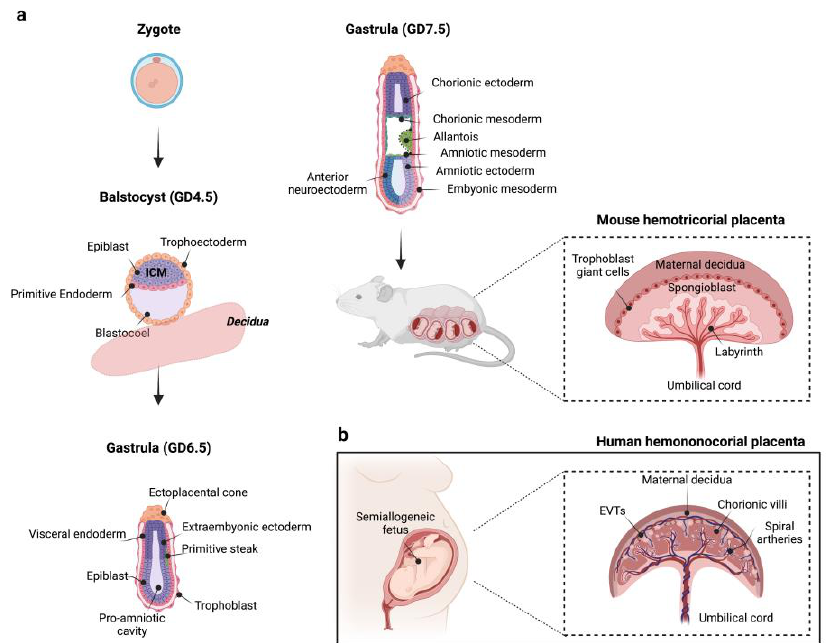
Figure 1. ( a ) A schematic representation of mouse placenta development. At gestational day (GD) 3.5–5.0, the mouse blastocyst is composed by ICM, which contains precursor cells for embryonic tissues (epiblast), and visceral and parietal endoderm (primitive endoderm), and by an outer cell layer called trophectoderm. Starting from GD 5.0–6.5, the polar trophectoderm differentiates in the ectoplacental cone, which gives origin to invading trophoblasts and junctional zone, and in the extraembryonic trophectoderm, which, in turn, gives rise to the chorionic ectoderm (GD 6.5–9.5). At the same time, the mesoderm (primitive streak) emerges between visceral endoderm and ectoderm tissues. Subsequently, the chorion fuses with mesodermal-derived allantois promoting placental labyrinth formation. As pregnancy progresses, a definitive placental structure becomes evident around the second week of gestation (GD 10–14.5). ( b ) A schematic representation of human placenta architecture. Figure created with “https://www.biorender.com/ (accessed on 18 January